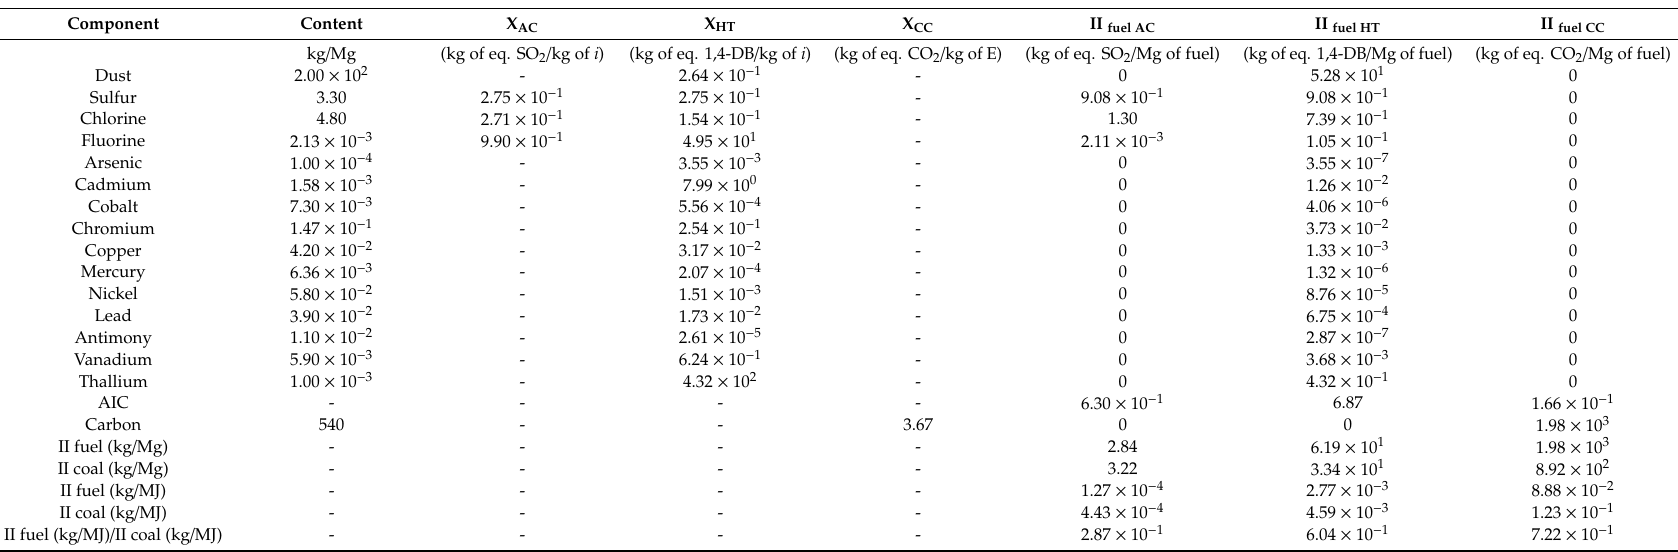
Table 4. Environmental harmful e ff ects of the waste mixture obtained during the second measurement